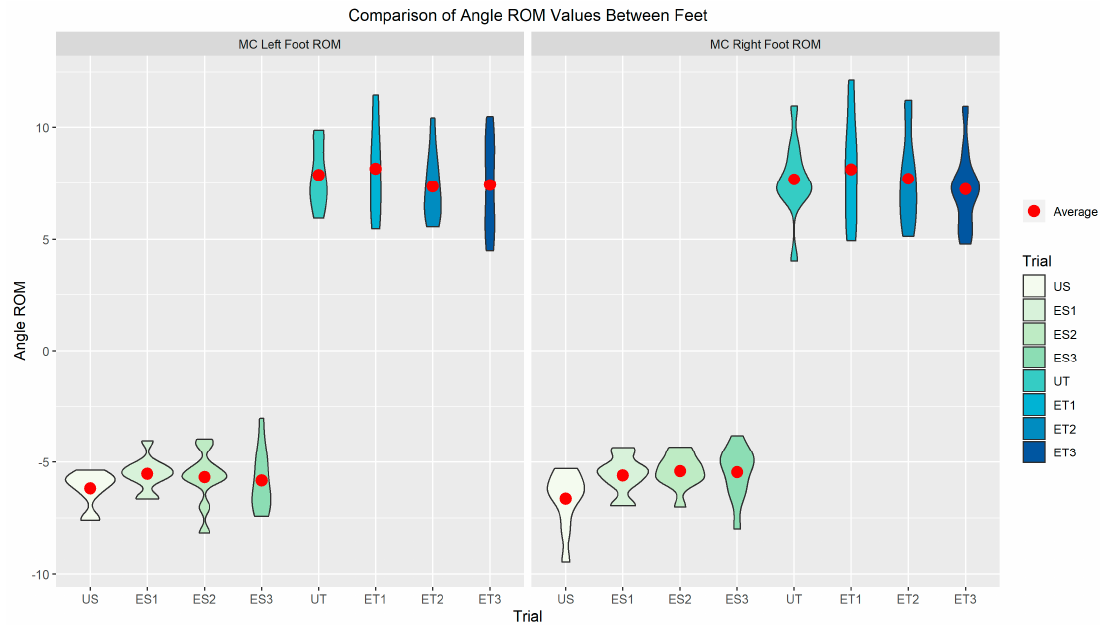
Figure 6. Spread and average ankle range of motion change for each foot across every trial; note that positive and negative changes occur respective to the trial with negative values indicating movement of ankle into PF and positive values indicate movement of ankle into DF.